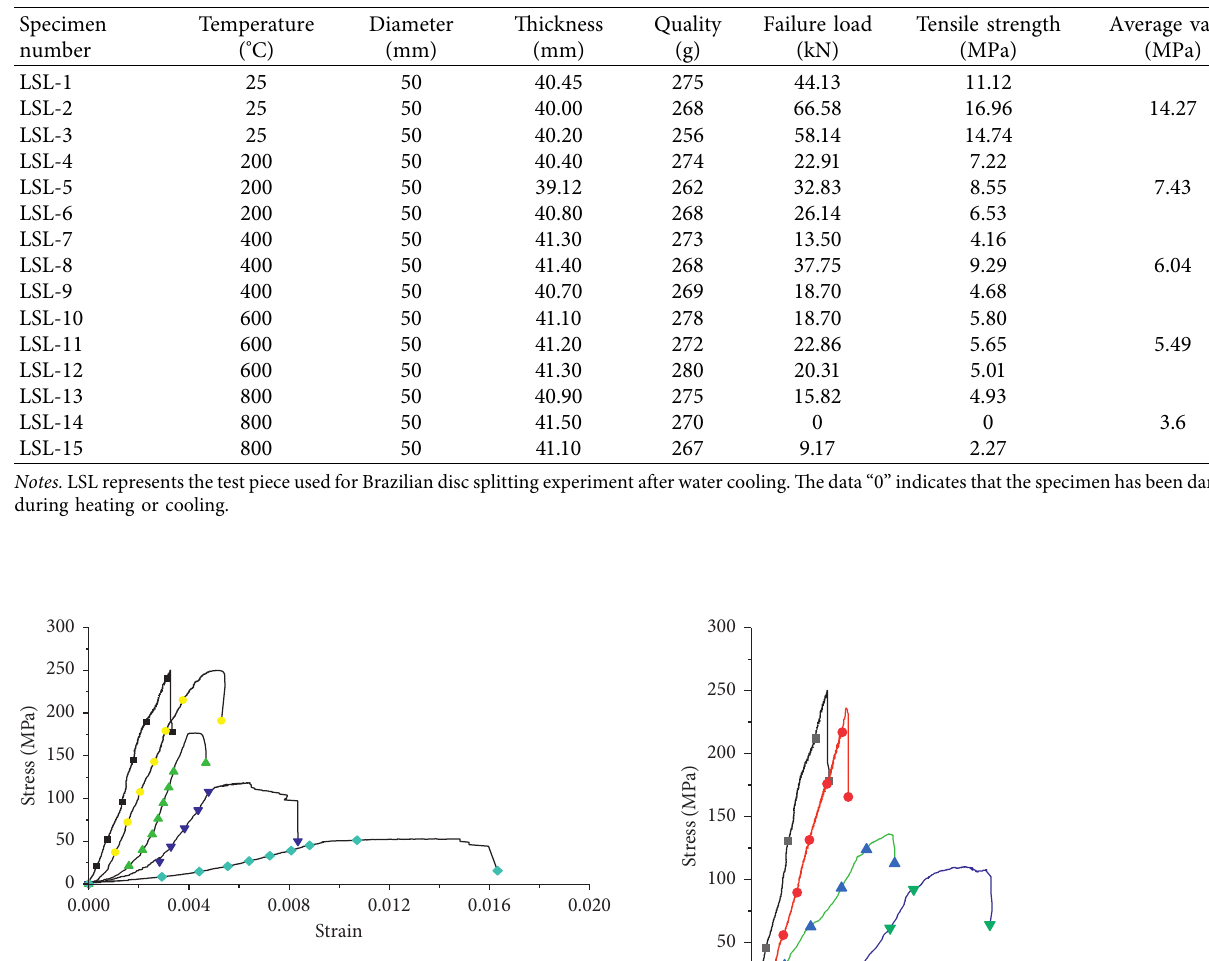
Table 4: Brazilian disc splitting experiment test data (water cooling).